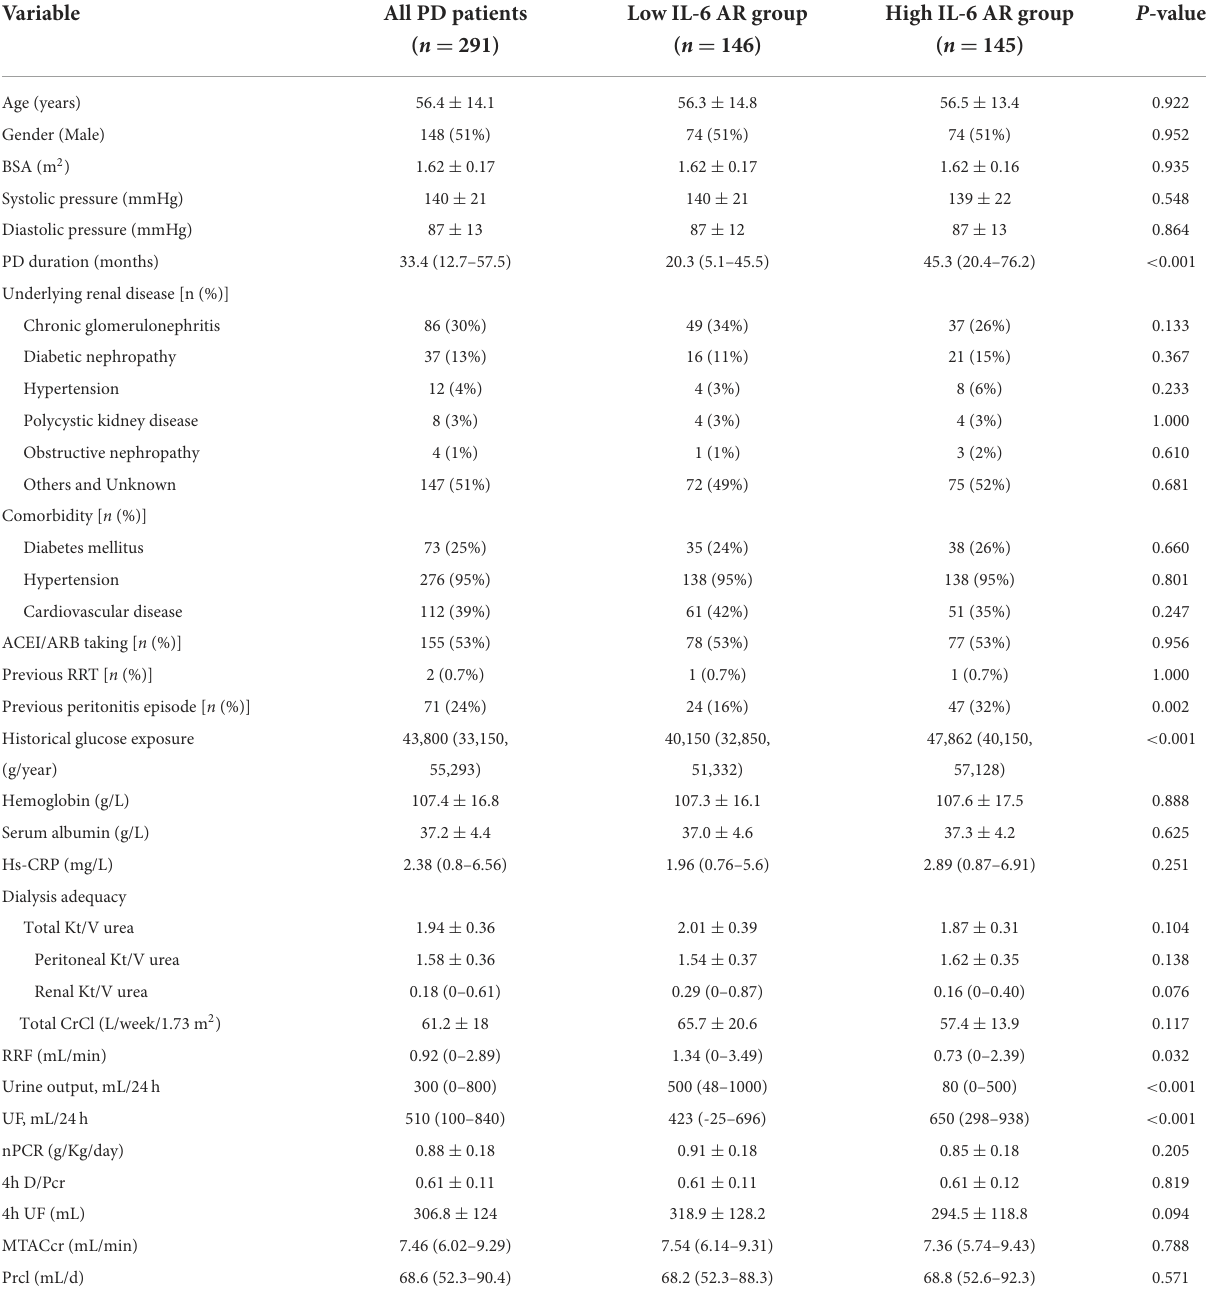
TABLE 1 Characteristics of the study population ( n =